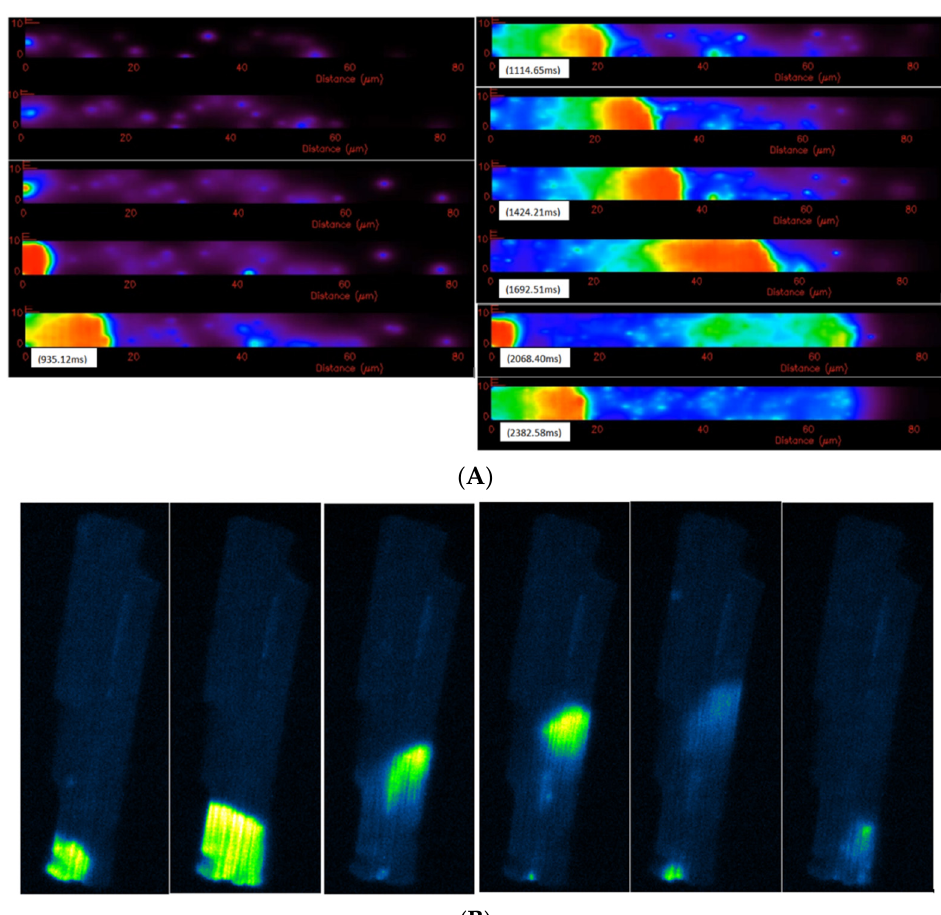
Figure 12. (A ) Calcium overload ([Ca] nsr = 1.7 mM, [Ca] i = 0.15 µM), this computational model of the